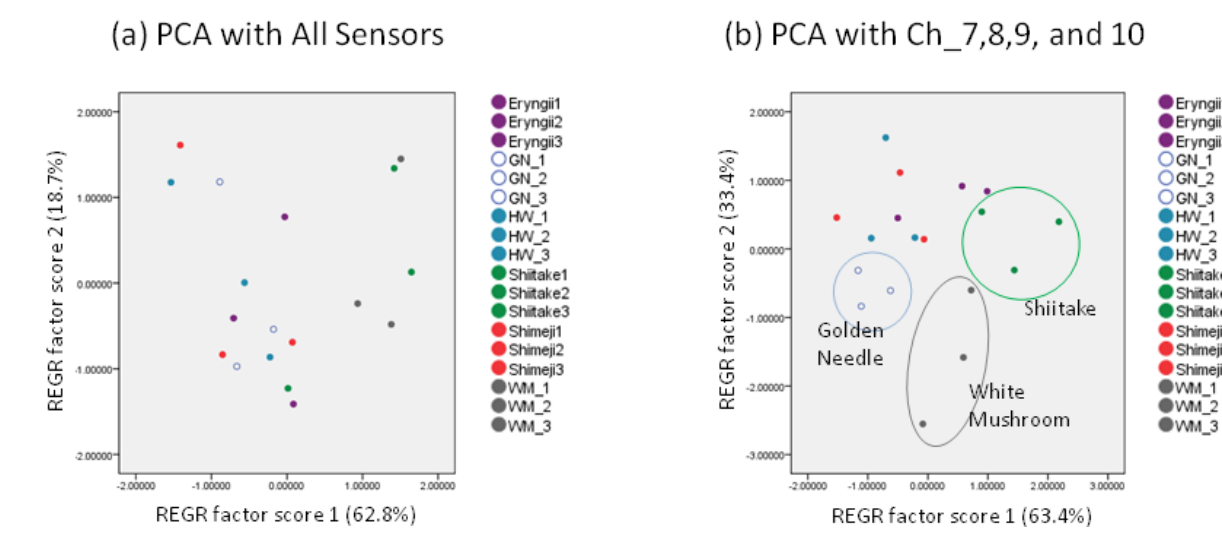
Figure 6. Mushroom discrimination by principal component analysis. ( a ) Principal component analysis using all sensor values; ( b ) principal component analysis using